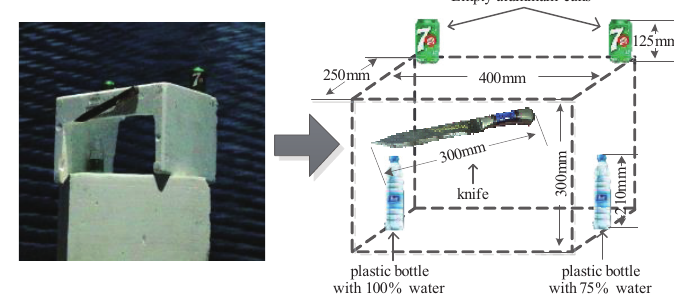
(cid:3) Figure 14. Assembly target